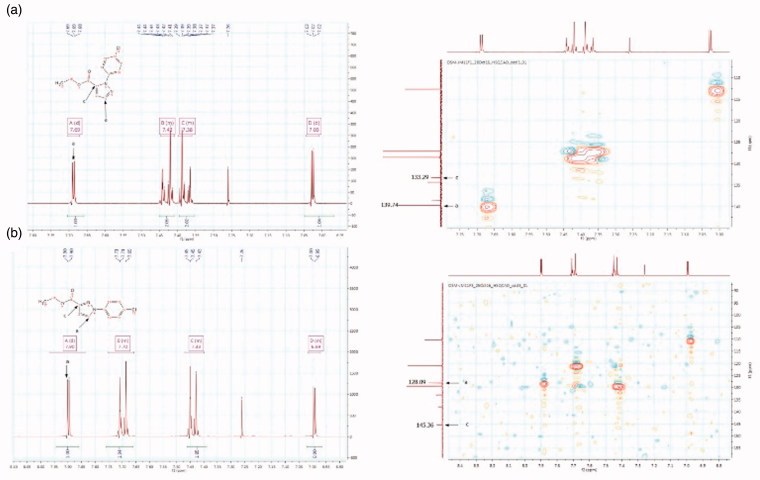
Enlargement of the 1H NMR and HMQC NMR of compounds 12d (a) and 13d (b).